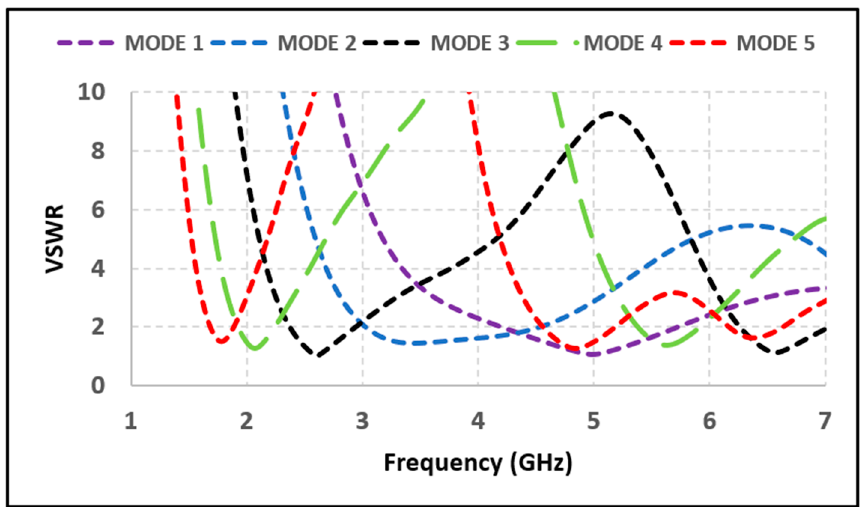
Figure 7. Voltage Standing Waves Ratio (VSWR) of proposed antenna at various operating modes.